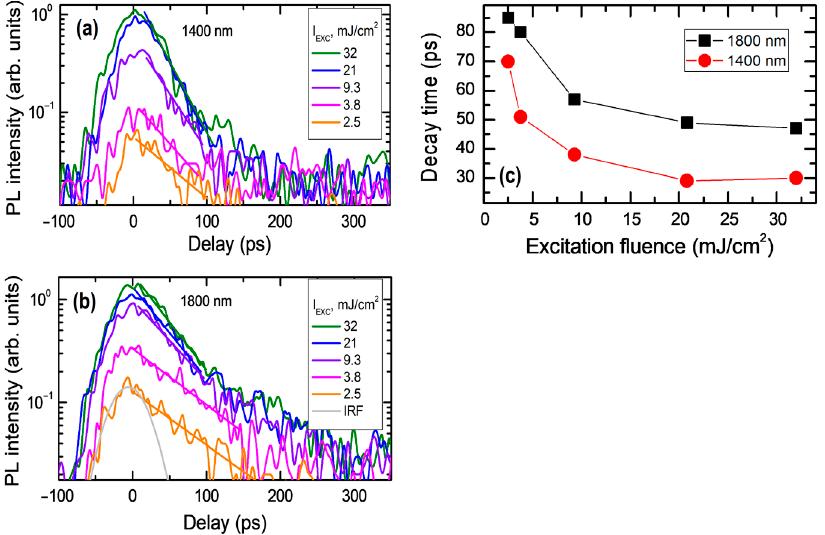
Figure 6. Excitation fluence ( a ) and temporal ( b ) dependencies of PL spectra at 32 mJ/cm 2 excitation. In ( b ), CW spectra obtained using an infrared spectrometer are shown for comparison.